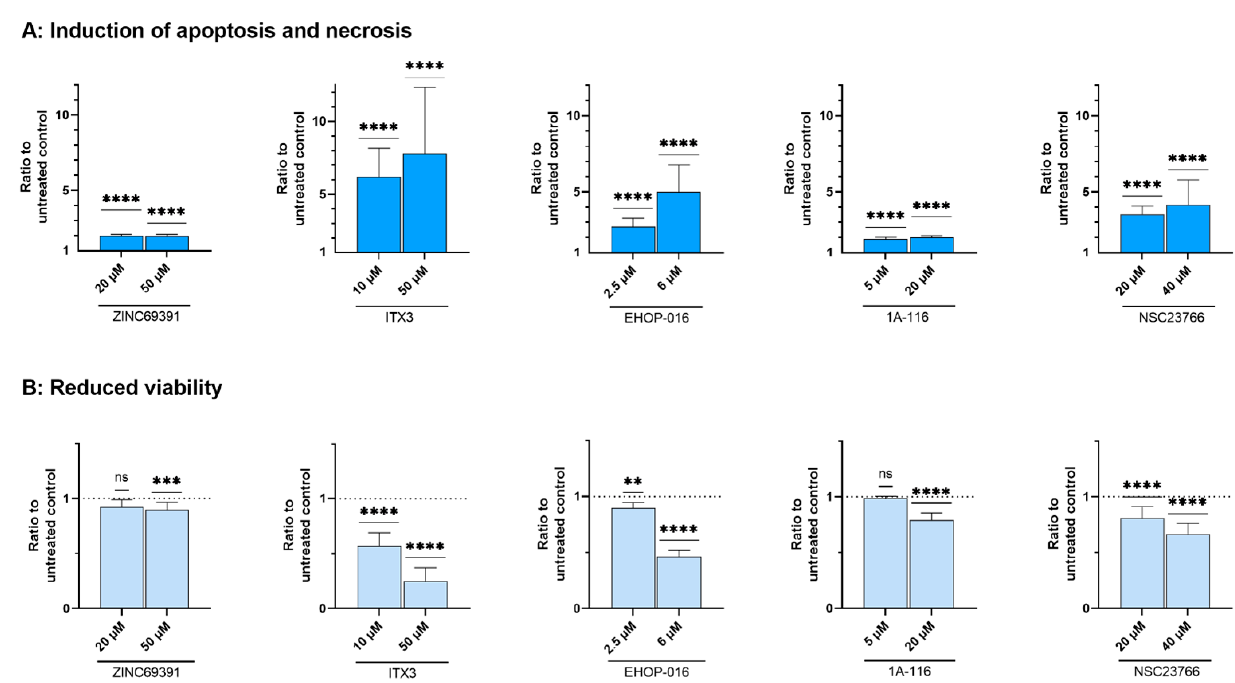
Figure 3. Results of the Annexin V/PI apoptosis assay. Flow cytometric assay to evaluate viability, apoptosis, and necrosis after 48 h treatment of 68 patient-derived AML samples with Rac1 inhibitors, assessed with the Annexin V/Propidium Iodine (PI) apoptosis assay. The results are presented as a ratio to the untreated control set to 1 (dotted line in ( B )). Columns represent medians with 95% CI as an error. For each Rac1 inhibitor, the graphs show ( A ) the induction of apoptosis and necrosis combined and ( B ) the cell viability with two different concentrations of the inhibitors. Wilcoxon signed- rank test was performed for evaluation against the untreated control set to 1. ns: non-significant. ** p < 0.01, *** p < 0.001, **** p <